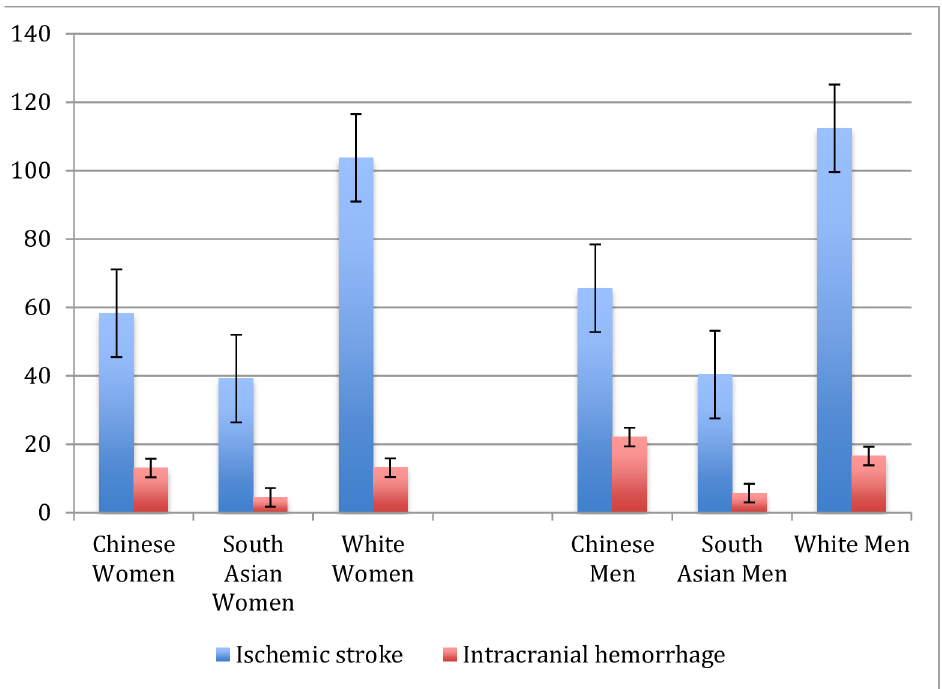
Fig 1. Age standardized stroke incidence with standard error by ethnicity and sex/ 100,000persons, 2010.